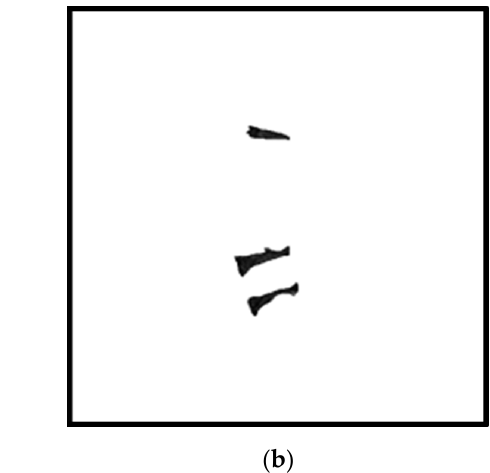
Figure 1. An example of an original spine MRI image and its corresponding standard masks of the three considered intervertebral discs: ( a ) the original spine MRI image; ( b ) the corresponding standard masks of the three intervertebral discs of ( a ).